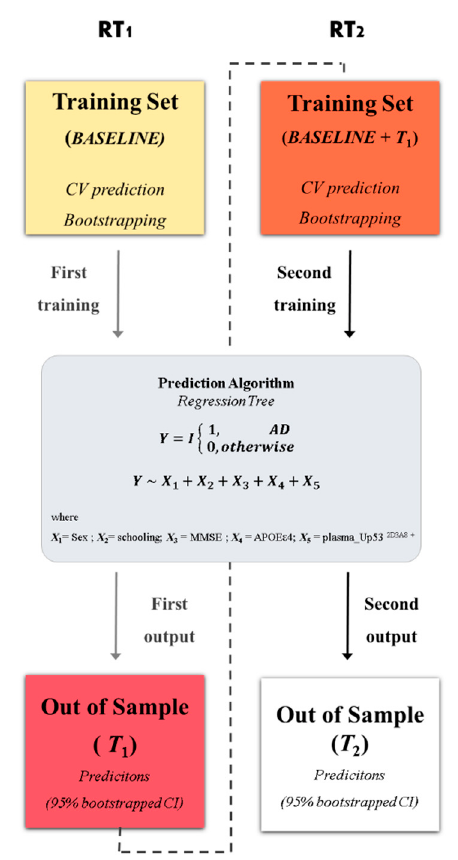
Figure 1. Statistical framework. The procedure for obtaining the optimal decision tree with a rolling window procedure. In the first step, a regression tree (RT1) algorithm was trained on InveCe.Ab data at baseline (first training set represented by a yellow box). The model was grown using five covariates (X1, . . . , X5, listed in the grey box), which predict the dichotomized diagnosis (outcome: non-Alzheimer’s disease (AD) = 0; AD = 1). The output obtained was then tested on T1 (first window, red box), an independent dataset collected on the same patients after two years. In the second step, the training set was reinforced by joining baseline and T1 (second window, orange box); the same model in the grey box was calibrated on it (RT2) and tested on T2 (second window, white box). RT predictions were bootstrapped, obtaining a 95% CI. Additional information on the procedure is provided in Table S7 and Figure S5.